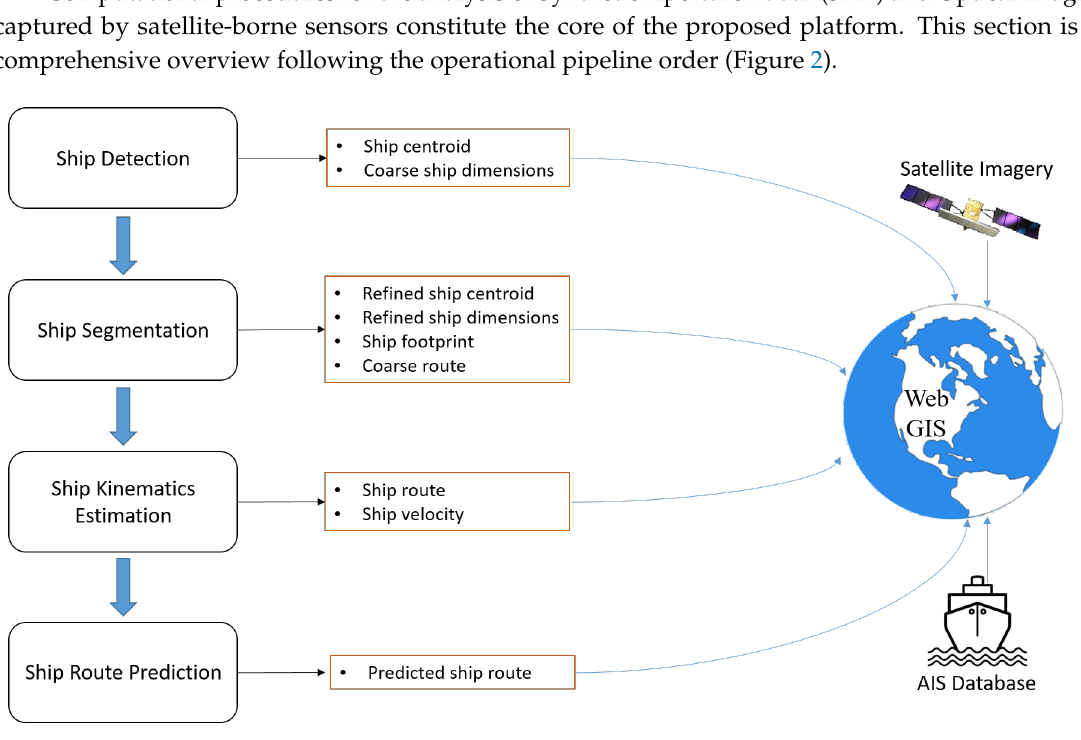
Figure 2. Proposed platform processing